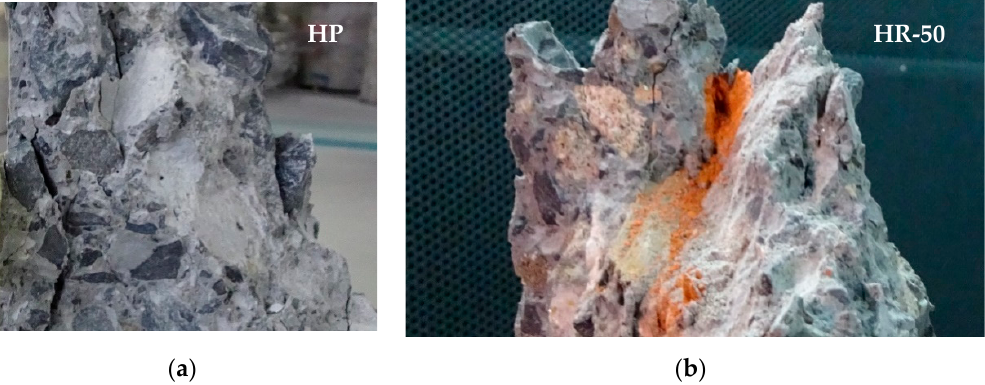
Figure 13. Fracture surface detail of samples broken during fatigue tests: HP sample ( a ) and HR-50 sample ( b ).